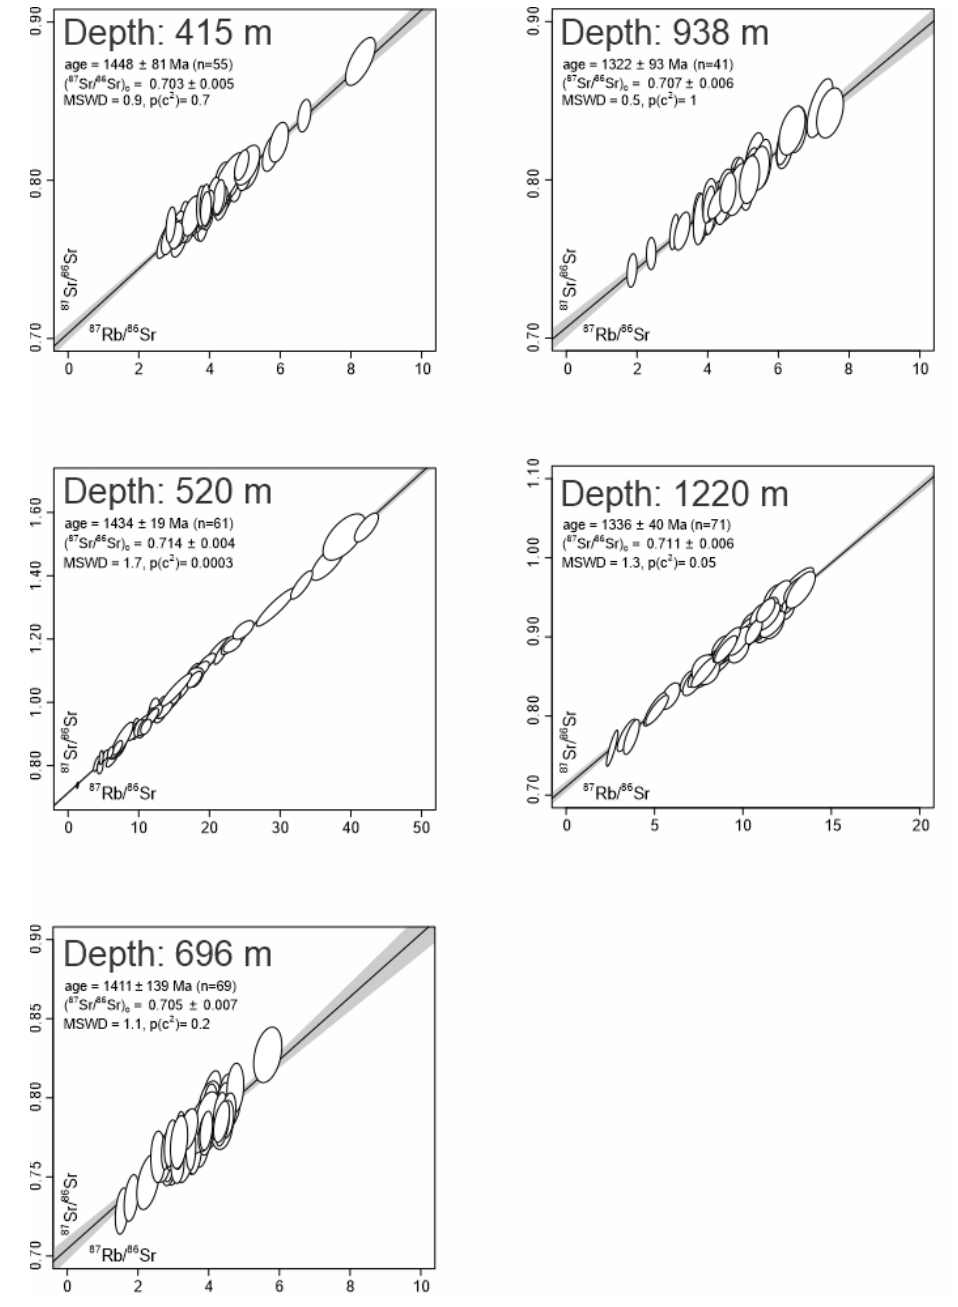
Figure 6. Summary of in situ Rb–Sr geochronological results from this study.